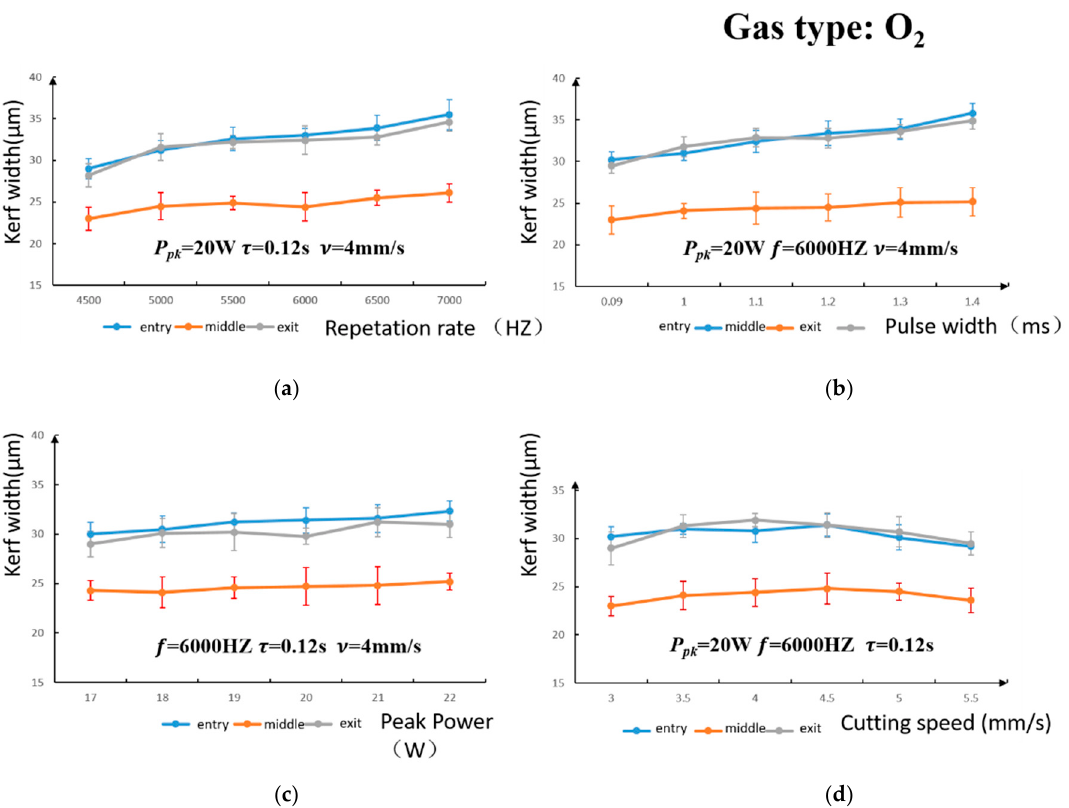
Figure 10. Influence of the process parameters on the kerf width: ( a ) repetition rate; ( b ) pulse width; ( c ) power; ( d ) cutting speed.